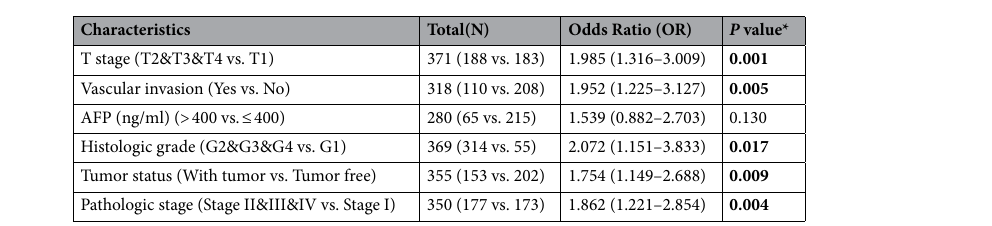
Table 2. Logistics regression model of MMP1 (TCGA-LIHC). p value < 0.05 was considered statistically significant (highlighted in bold).